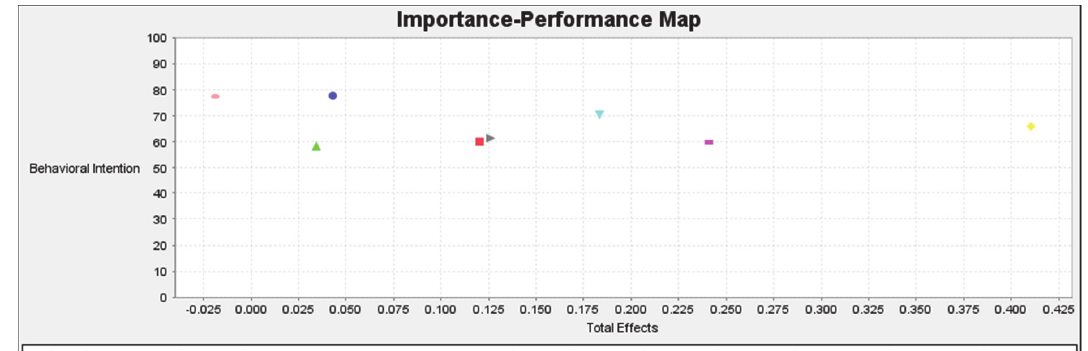
Fig. 2. Importance performance matrix analyses